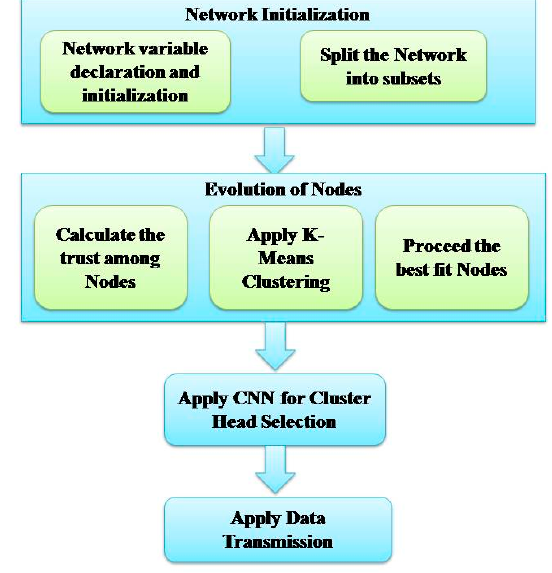
Figure 1. The architecture of the proposed hybrid model.